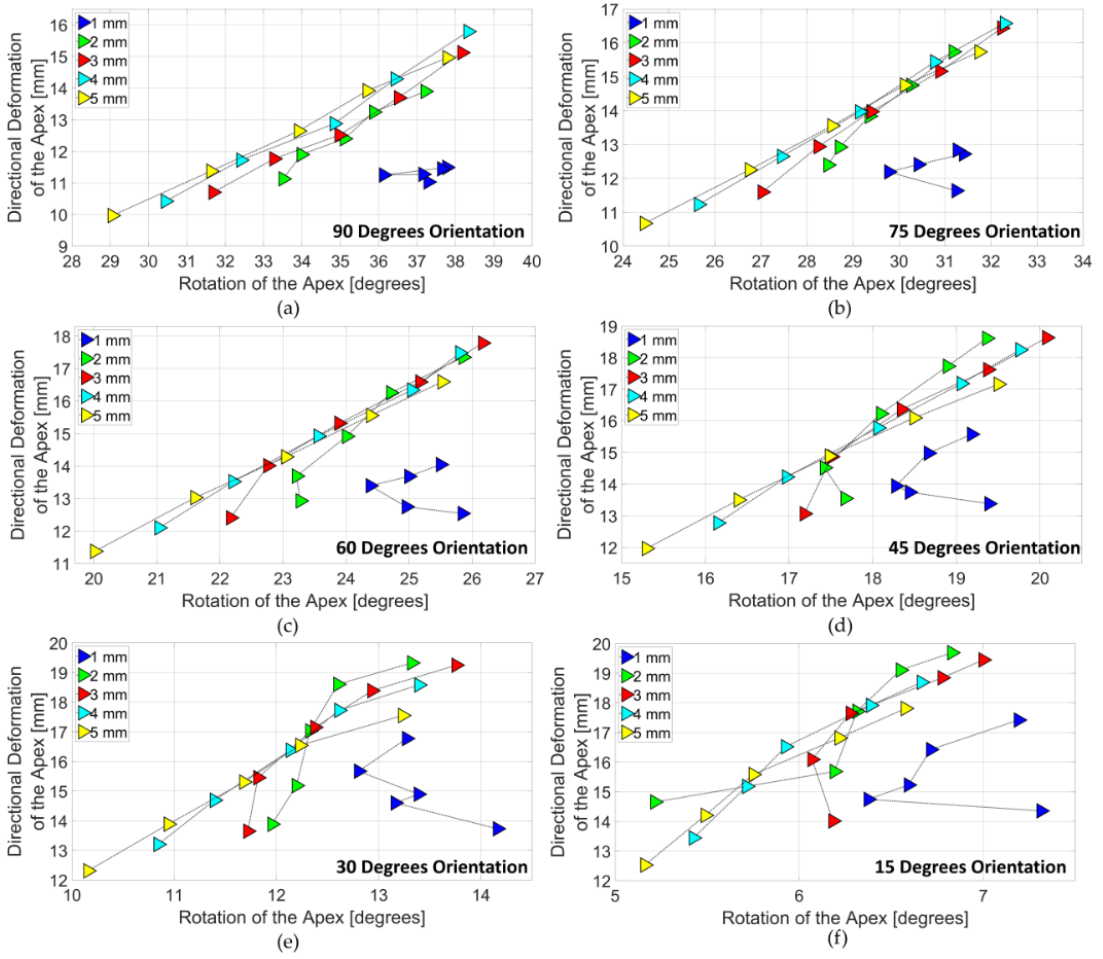
Figure 11. ( a ) 90 degrees subdomain; ( b ) 75 degrees subdomain; ( c ) 60 degrees subdomain; ( d ) 45 degrees subdomain; ( e ) 30 degrees subdomain; ( f ) 15 degrees subdomain.